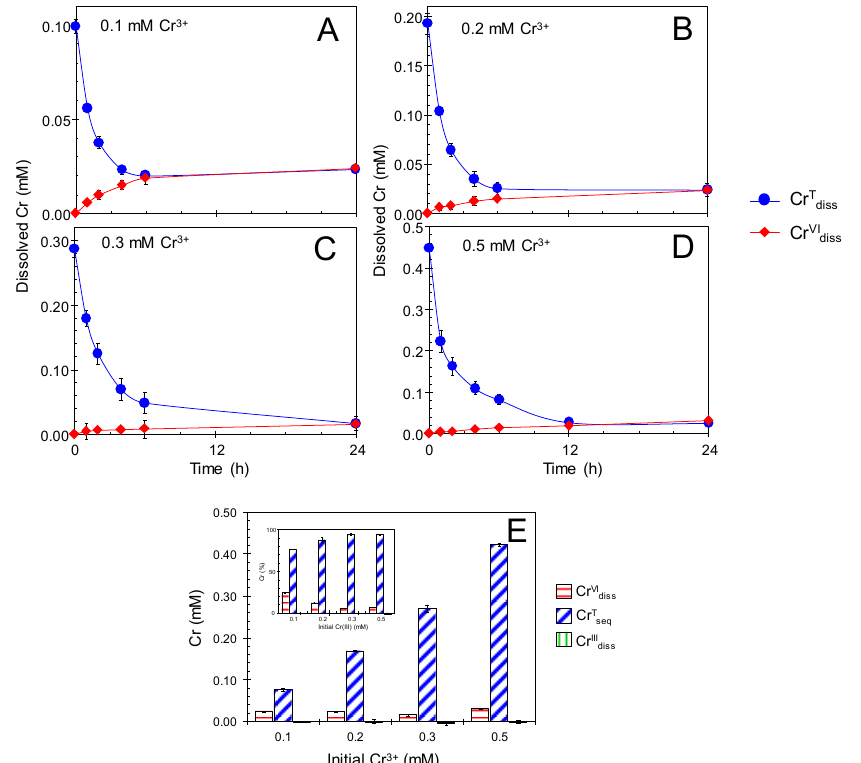
Figure 5. Single treatment of heated biogenic manganese oxides (BMOs; 1 mM as Mn) with 0.1–0.5 mM Cr(NO 3 ) 3 under aerobic conditions at pH 6.0 (100 mM MES bu ff er). ( A – E ) Concentrations of total Cr dissolved (Cr T diss ) and Cr(VI) dissolved (Cr VI diss ). Initial Cr(NO 3 ) 3 concentrations were: ( A ) 0.1 mM, ( B ) 0.2 mM, ( C ) 0.3 mM, and ( D ) 0.5 mM. ( E ) Concentrations (inset: percentages) of total Cr sequestered (Cr T seq ), Cr(VI) dissolved (Cr VI diss ), and Cr(III) dissolved (Cr III diss ) after the treatments. Data are shown as mean ± standard deviation (n = 3).